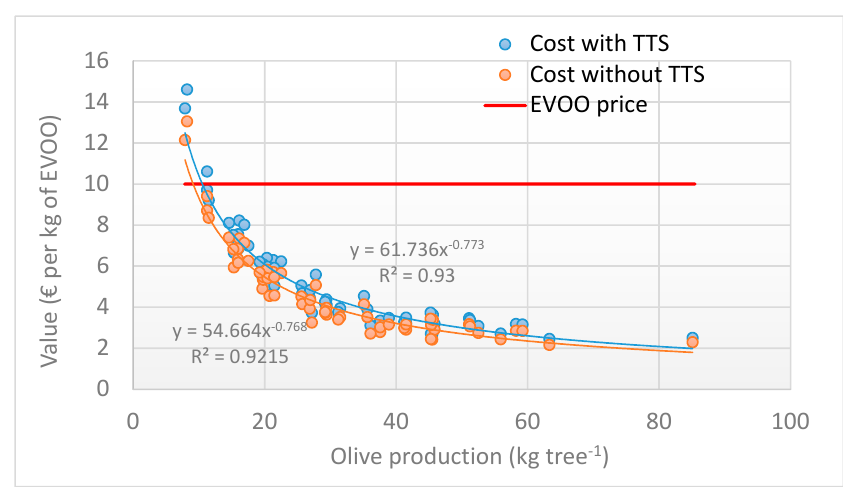
Figure 13. Comparison between harvesting cost, with or without TTS, and the EVOO market price as a function of olive production per tree.